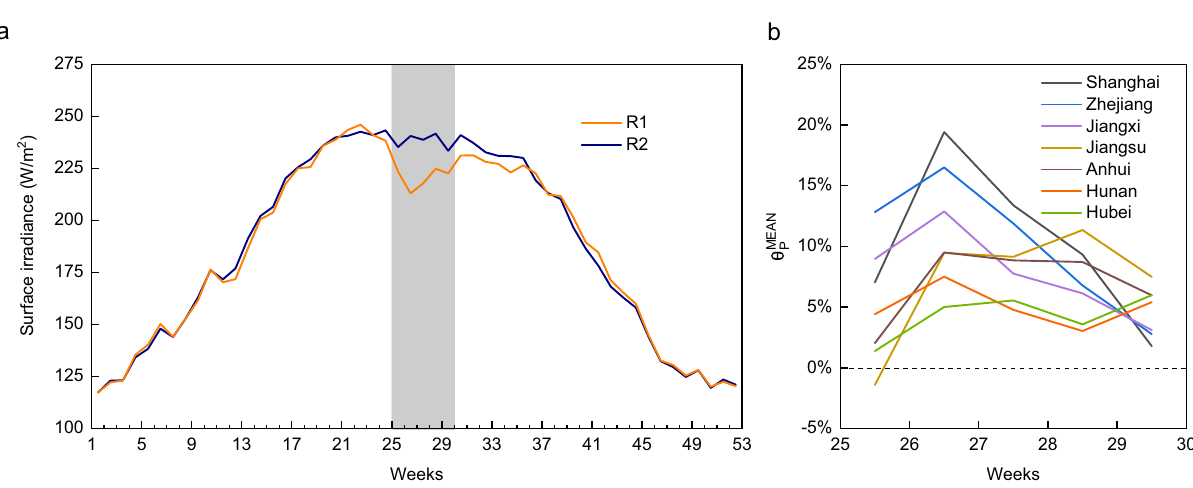
Fig. 1 Plum rain effects on the surface irradiance (SI) in the affected region (R1). a The 52-week SI within a year, where R2 denotes the unaffected surrounding region. b Impact degree of plum rain on the SI from the 25th week to the 29th week, where θ P rain on the SI in each province or